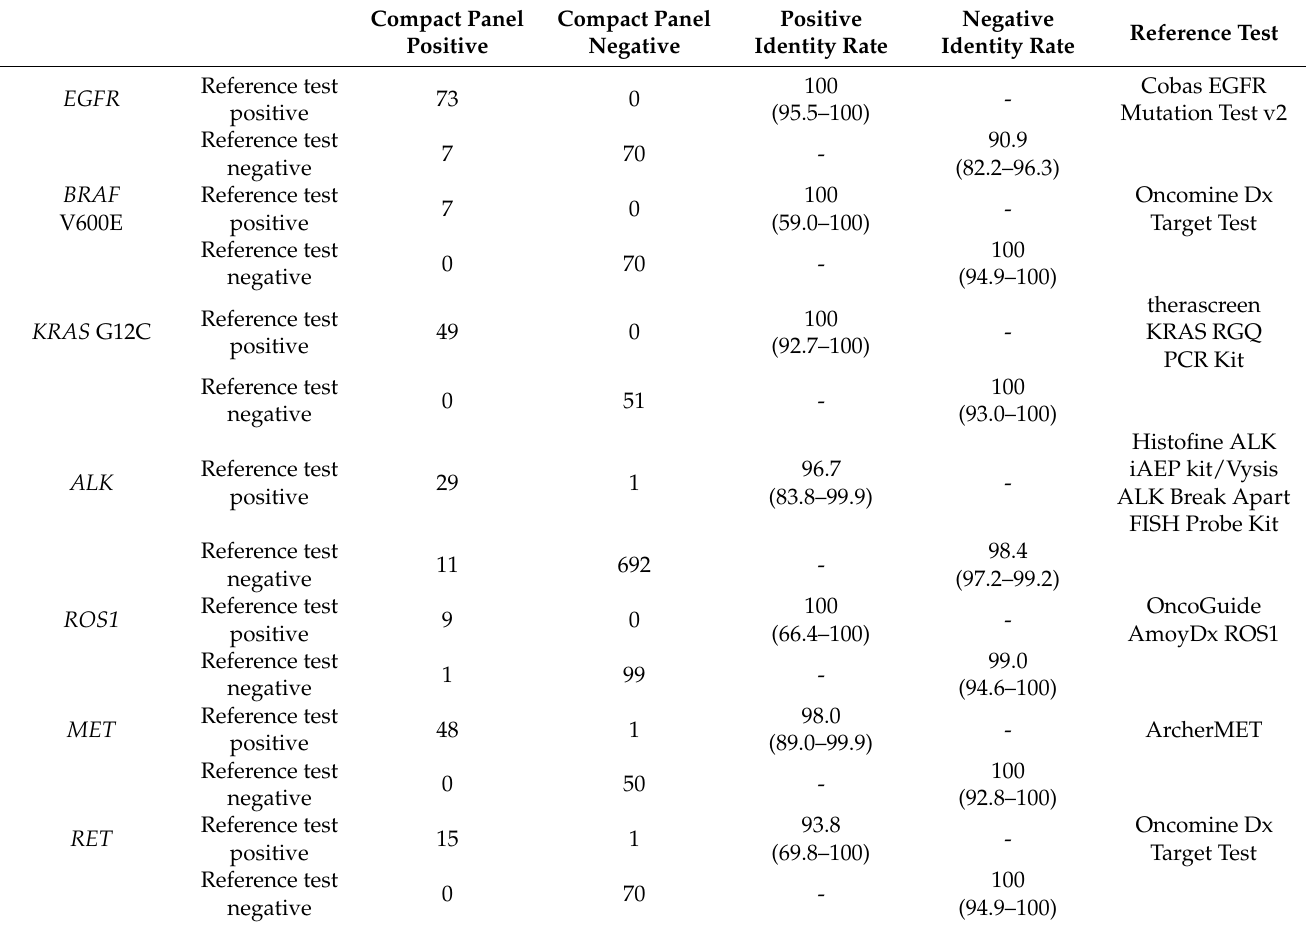
Table 3. Concordance of the compact panel with approved diagnostic tests. Parentheses in identity rates indicate a 95% confidence